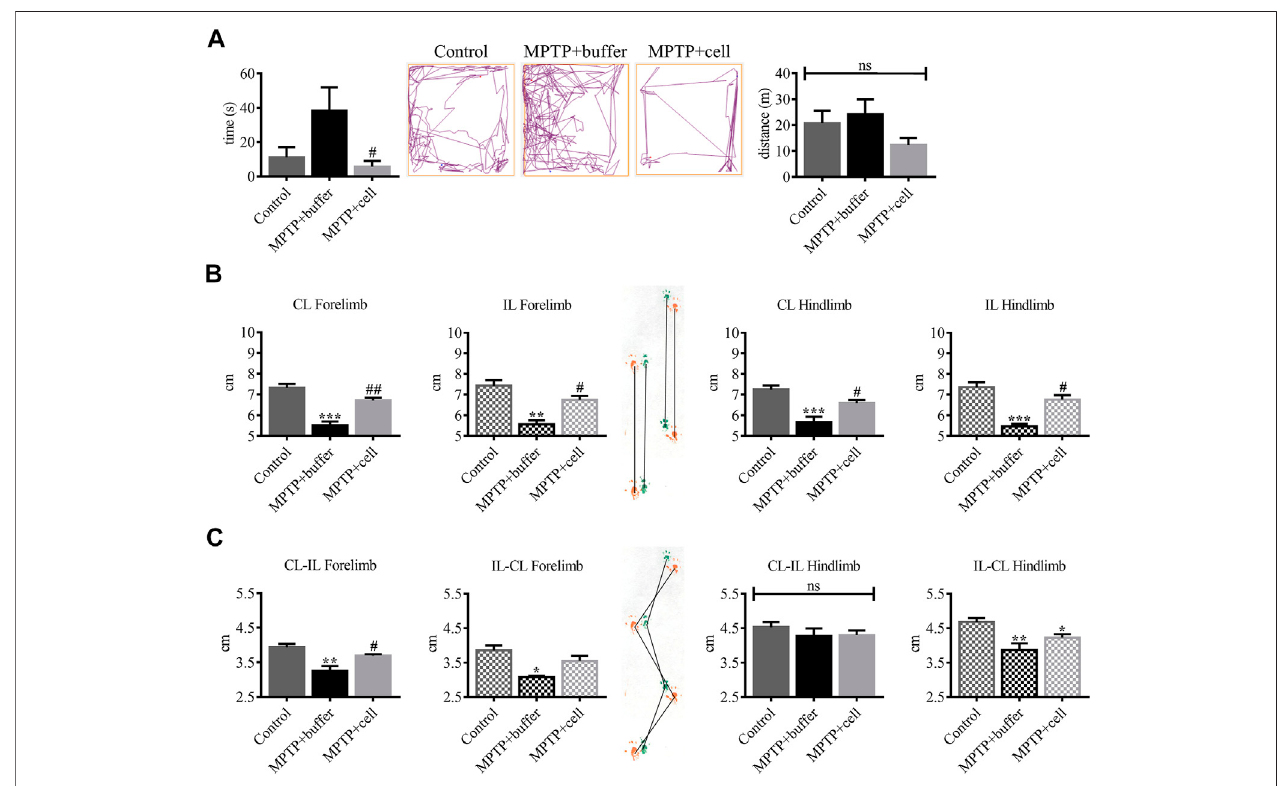
FIGURE 5 | Behavioral improvement was observed in hNSC-transplanted mice. (A, left) Buffer-treated animals had a tendency to spend 71% more time in the centeroftheboxcompared tocontrols,whileNSC-transplanted micespent85%lesstime inthecentercomparedtothosethatreceivedbuffer( p < 0.05).Control n (cid:1) 5, MPTP + buffer n (cid:1) 4, MPTP + cell n (cid:1) 5. One-way ANOVA followed byTukey´spost-hoc test. (A, right) All experimental groups had the same distancetraveled.Control n (cid:1) 5, MPTP + buffer n (cid:1) 4, MPTP + cell n (cid:1) 5. Kruskal-Wallis test. (B) Forelimb and hindlimb stride lengths decreased by approximately 24% in buffer-treated animalscomparedtocontrols( p < 0.01),andhNSCtransplantledtoa17%increaseinallstridelengthsmeasuredcomparedtothevehiclegroup( p < 0.05). (C) Forelimb stride width was around 19% shorter inbuffer-treated mice compared to control animals ( p < 0.05) and NSC transplanttended to increase forelimb stride width by 13% comparedtomicethatreceivedbuffer,althoughonlyattainingsigni fi cance( p < 0.05)ononesidemeasured.CL-ILhindlimbstridewidthwasunchangedamongthethree experimentalgroupsandwhencomparedtothecontrolgroup,IL-CLhindlimbstridewidthwasreducedinallMPTP-lesionedmice,althoughtoagreaterextentinbuffer- treated (17%; p < 0.01) than cell-transplanted animals (10%; p < 0.05). (B,C) : Control n (cid:1) 7, MPTP + buffer n (cid:1) 3, MPTP + cell n (cid:1) 5. One-way ANOVA followed by Tukey ’ s post-hoc test. (A – C) : *, # (cid:1) p < 0.05, **, ## (cid:1) p < 0.01, *** (cid:1) p < 0.001, ns, not signi fi cant. * (cid:1) compared to control, # (cid:1) compared to MPTP + buffer. Data are expressed as mean ± standard error of the